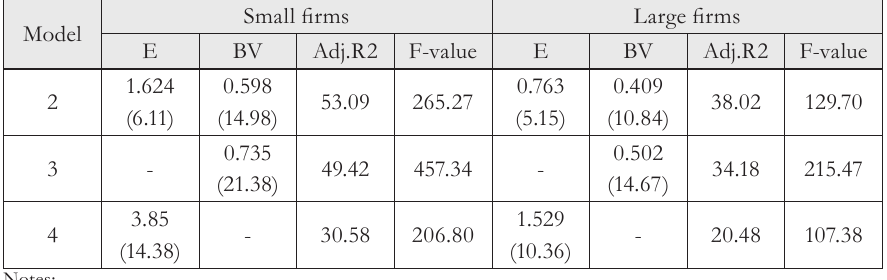
Tab. 3 - Value relevance of earnings and book value with firm size. Source: Own